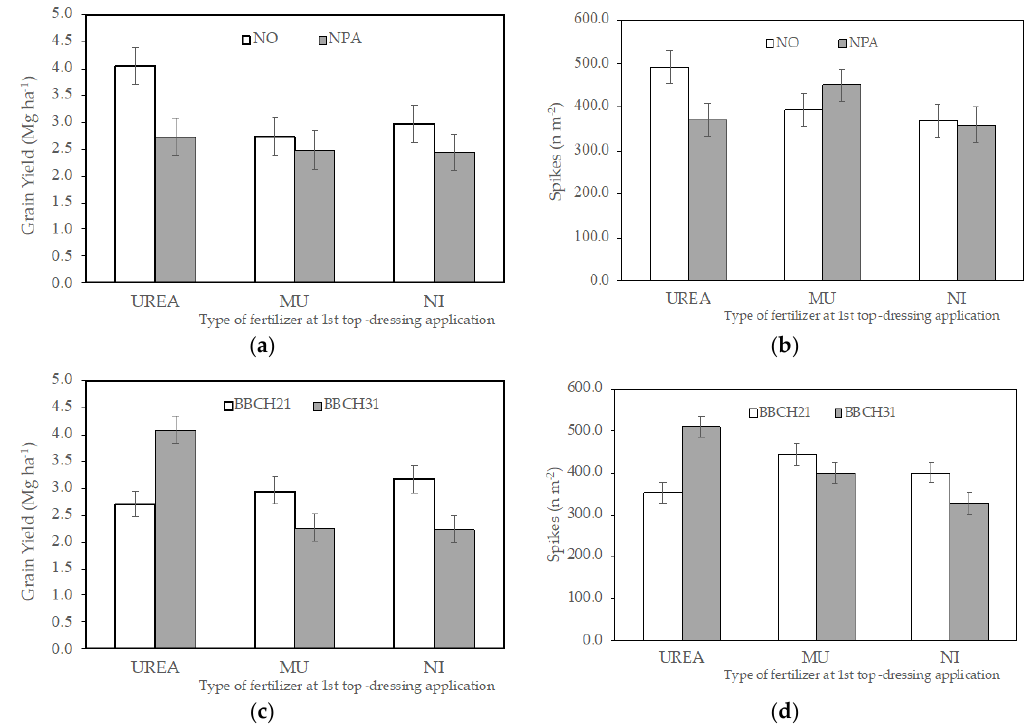
Figure 2. N source interaction effects at Pisa: ( a ) Grain yield (N source × N rate interaction); ( b ) Spike number per unit area (N source × N rate interaction); ( c ) Grain yield (N source × N timing interaction); ( d ) Spike number per unit area (N source × N timing interaction). Vertical bars represent LSD ( p = 0.05).